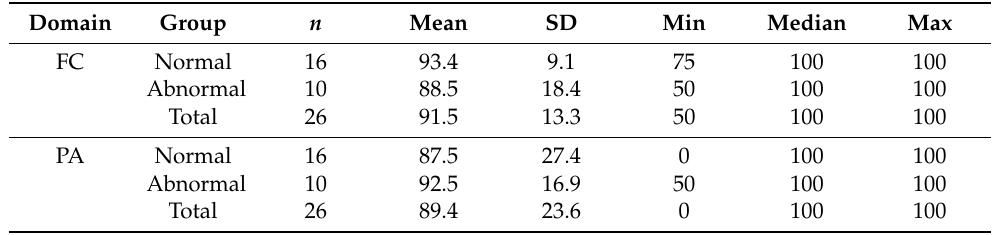
Table 3. Descriptive statistics for scores in the SF-36 domains for the Normal and Abnormal BAEPs